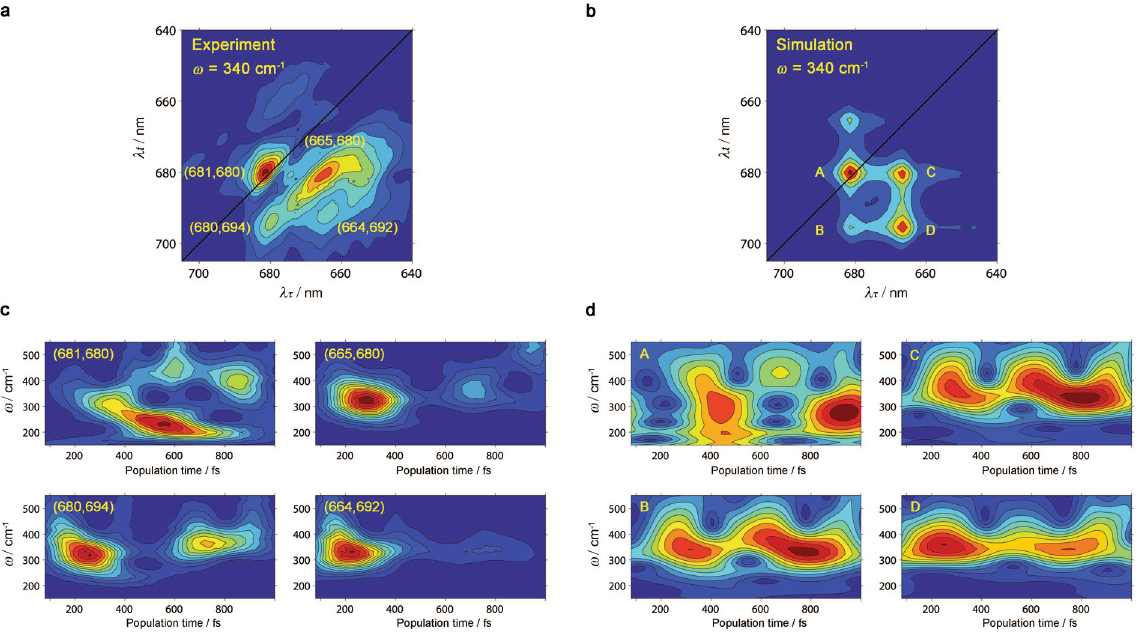
Figure 3. Comparison of experimental vibronic coherence dynamics in PSII RC at 80 K and simulations of the classical undamped wave packet dynamics of a single electronic transition (simulation details given in the main text). ( a ) The experimental 2D frequency map at 340 cm − 1 (reproduced from ref. 12). ( b ) The simulated 2D frequency map at 340 cm − 1 , showing the predicted five peak pattern 11, 13, 17 . ( c ) Experimental wavelet scalograms computed at the peak positions indicated in ( a ). ( d ) Wavelet scalograms computed for the simulated peak positions indicated in ( b ). Recurrence of signals in both ( c ) and ( d ) are consistent with the beating envelope due to vibrational coherences with closely spaced frequencies, but the decay of signals in ( c ) points to additional electronic dynamics at certain peak